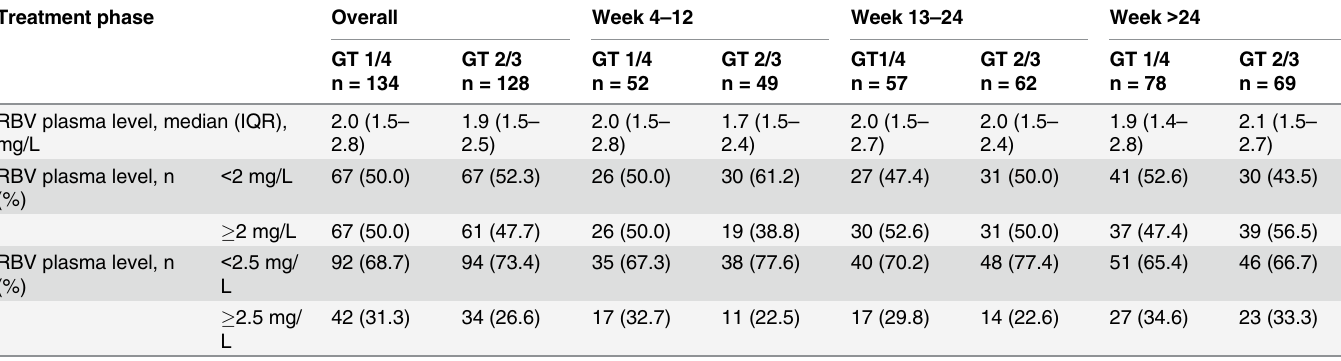
Table 2. Ribavirin plasma concentration overall and in different treatment phases. Treatment phase